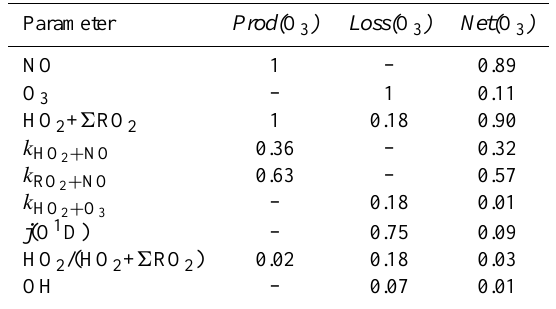
Table 2. Campaign average of sensitivity indexes (Eq. 6) for Prod( O 3 ) , Loss( O 3 ) and Net( O 3 ) .